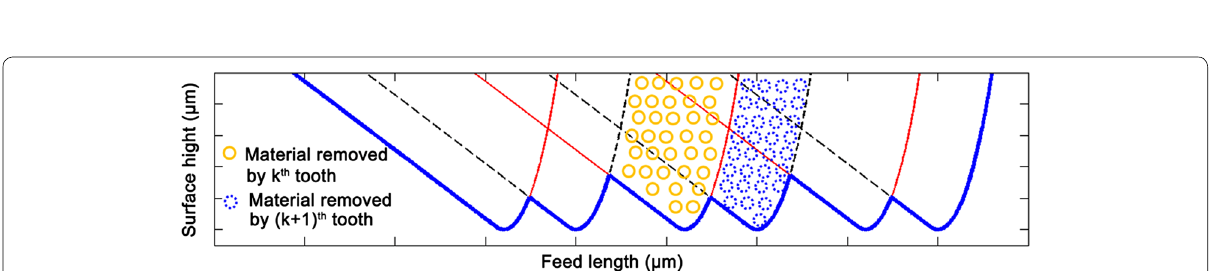
Figure 4 Influence of radial runout on surface generation